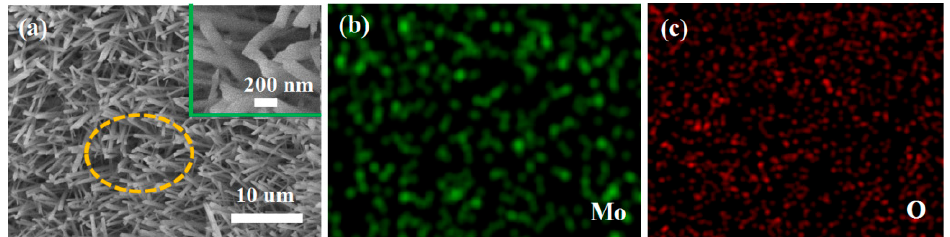
Figure 2. Morphology of the as-synthesized MoO3 nanorods ( a ) Low magnification SEM image and the inset is the high magnification SEM images; ( b , c ) SEM mapping images of the yellow section from ( a ).